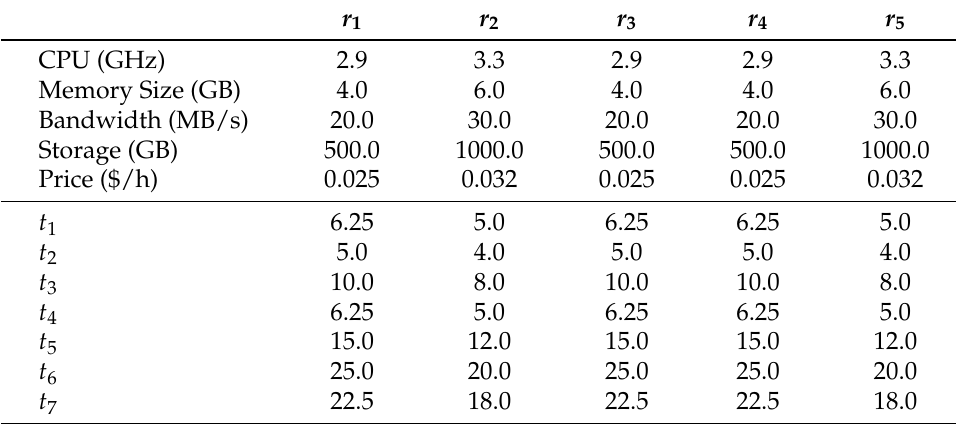
Table 1. Examples of task execution time (in minute).